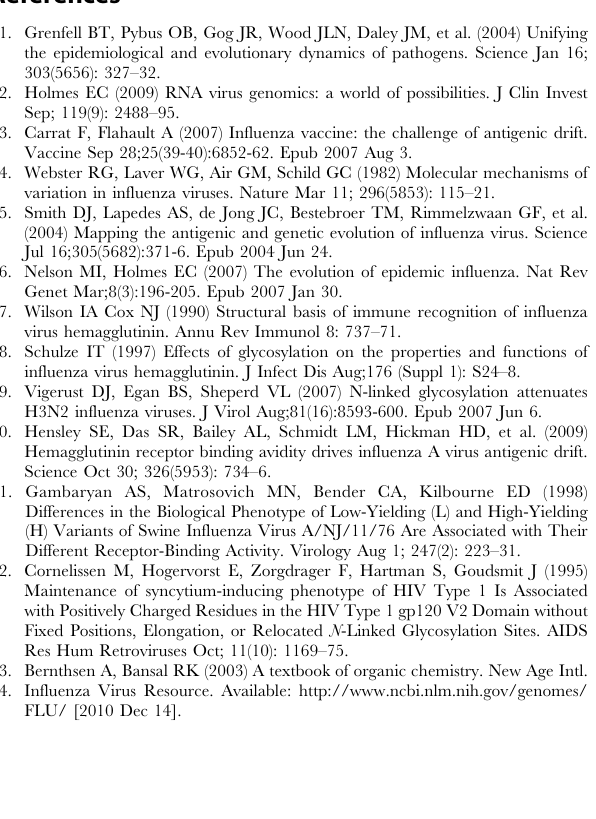
Figure S4 HA and NA charge distribution for two illustrative subtype/host species pairs. Other subtypes, and hosts, show a comparable behaviour, with no discernible pattern over